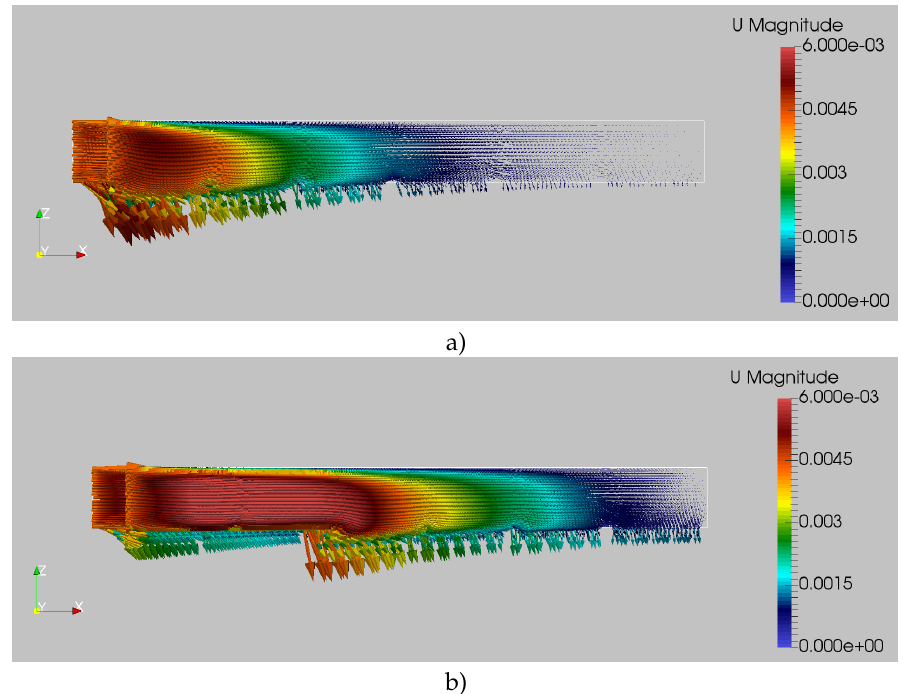
Figure 2. Outlet and plenum velocity distribution for different panel distributions: ( a ) constant panel distribution (Panel C); ( b ) optimized panel distribution (2 × Panel A, 2 × Panel B and 2 × Panel C) (taken from